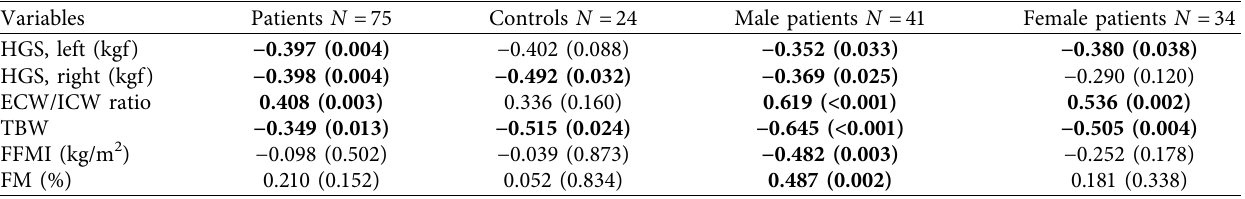
Table 3: Partial correlations, r value ( P value), between age handgrip strength and anthropometrical indices in all patients and controls and for male and female patients separately. Adjustments were done for sex, BMI, PAL, and MNA-total score in controls and adding UPDR-III in